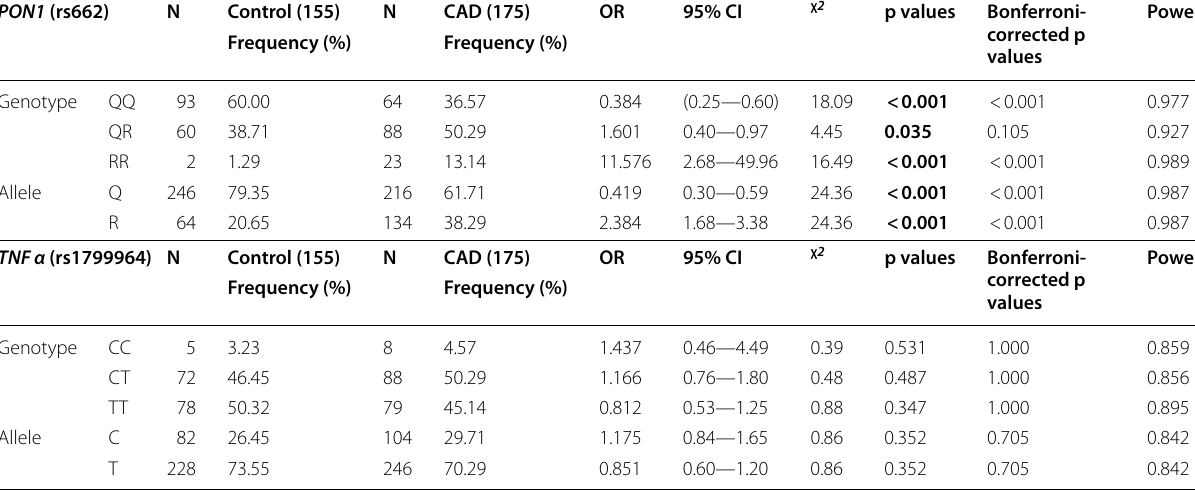
Table 2 The genotype, allele frequencies of PON1 (rs662) and TNF α (rs1799964) genes and their statistical analysis among CAD cases and